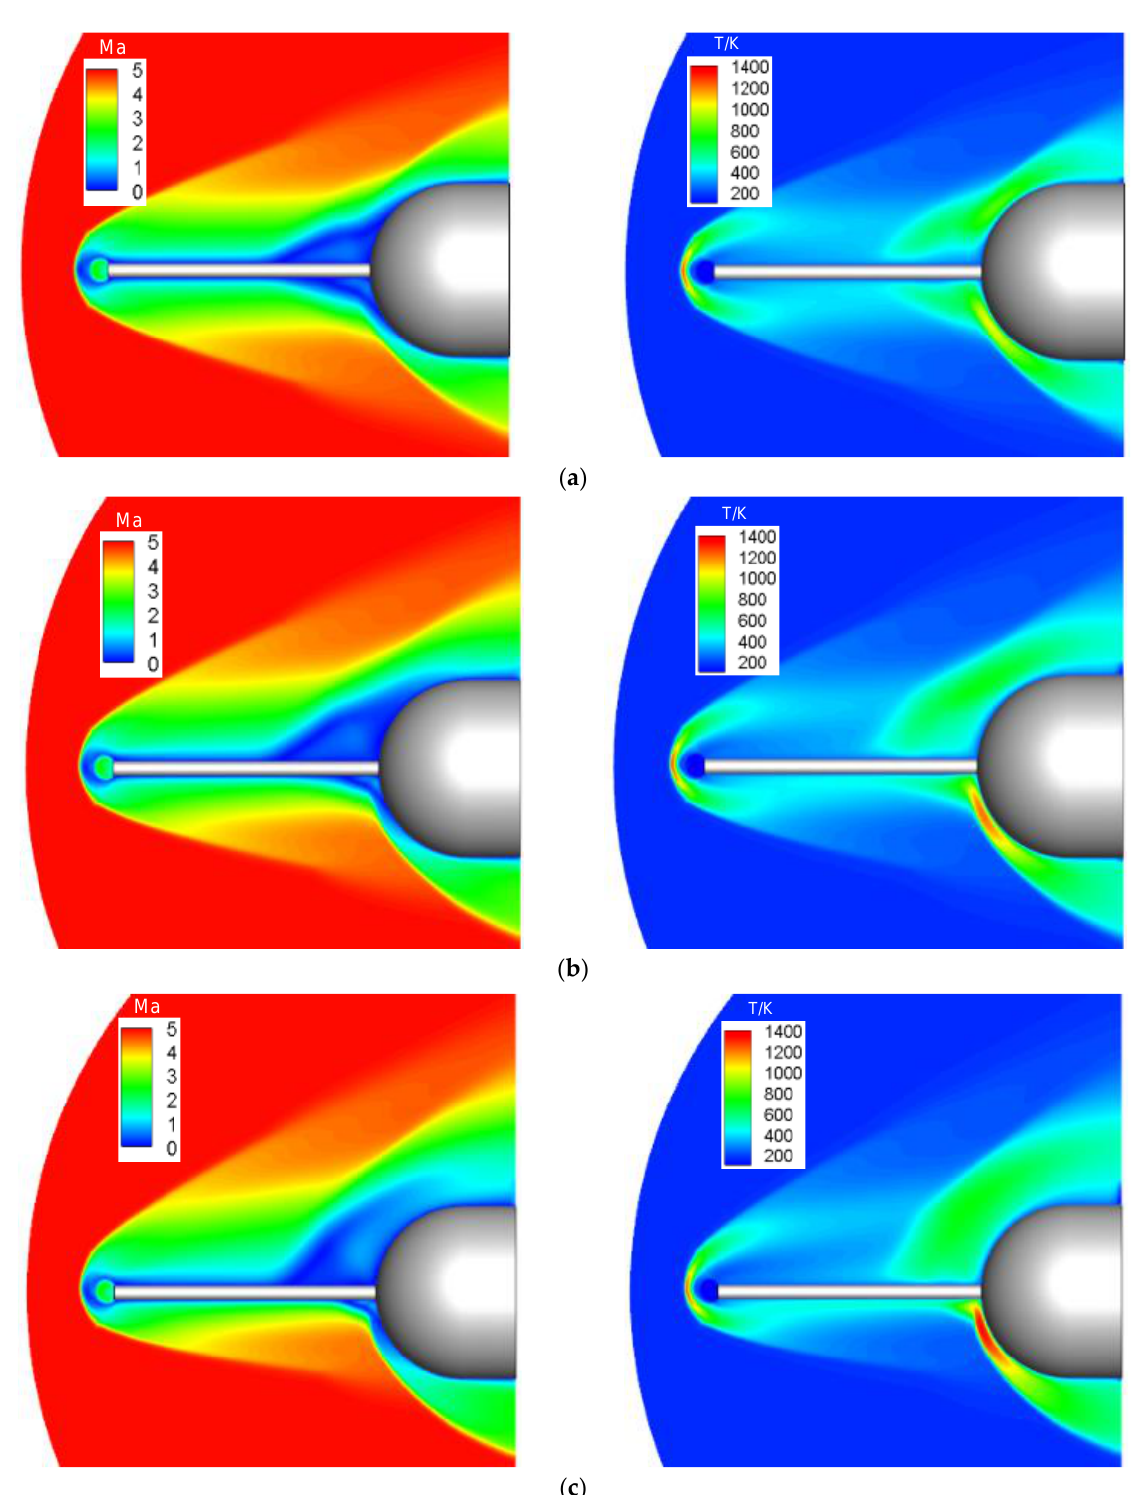
Figure 5. Numerical results of flow field: ( a ) α = 2°; ( b ) α = 6°; ( c ) α = 10°.